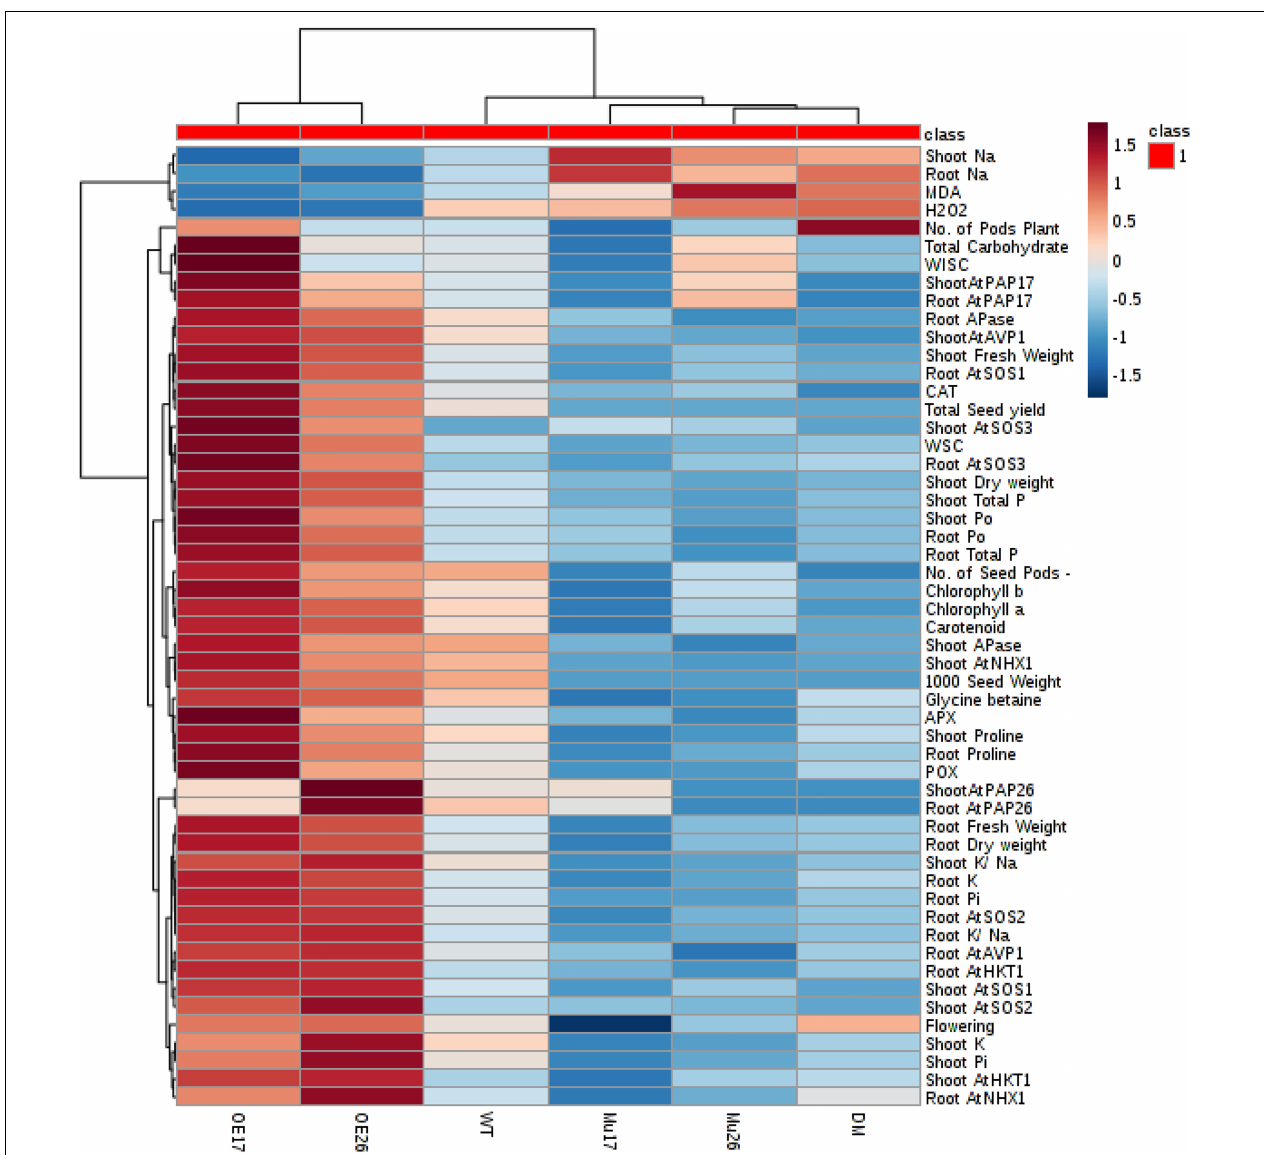
FIGURE 10 | A heat map of the impact of overexpression and knockout of AtPAP17 and AtPAP26 genes on the molecular, physiological, biochemical, and morphological parameters of the studied genotypes at 150 mM NaCl stress. Wild-type (WT), overexpress (OE), single mutant (Mu), and double mutant (DM) genotypes of Arabidopsis thaliana purple acid phosphatase 17 ( AtPAP17 ) and 26 ( AtPAP26 ) genes. The color key represents the quantile-normalized log10-transformed values. Dark red indicates high level whereas dark blue indicates low